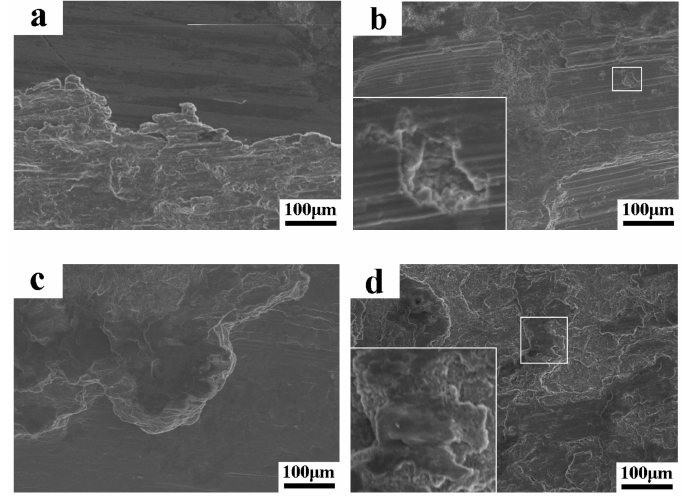
Figure 7. SEM morphologies of fretting wear scars in dry friction environment: ( a ) F n = 20 N, D = ± 150 µ m, 10 4 cycles, dry friction; ( b ) F n = 20 N, D = ± 150 µ m, 10 5 cycles, dry friction; ( c ) F n = 50 N, D = ± 150 µ m, 10 5 cycles, dry friction; ( d ) F n = 50 N, D = ± 150 µ m, 10 5 cycles, dry